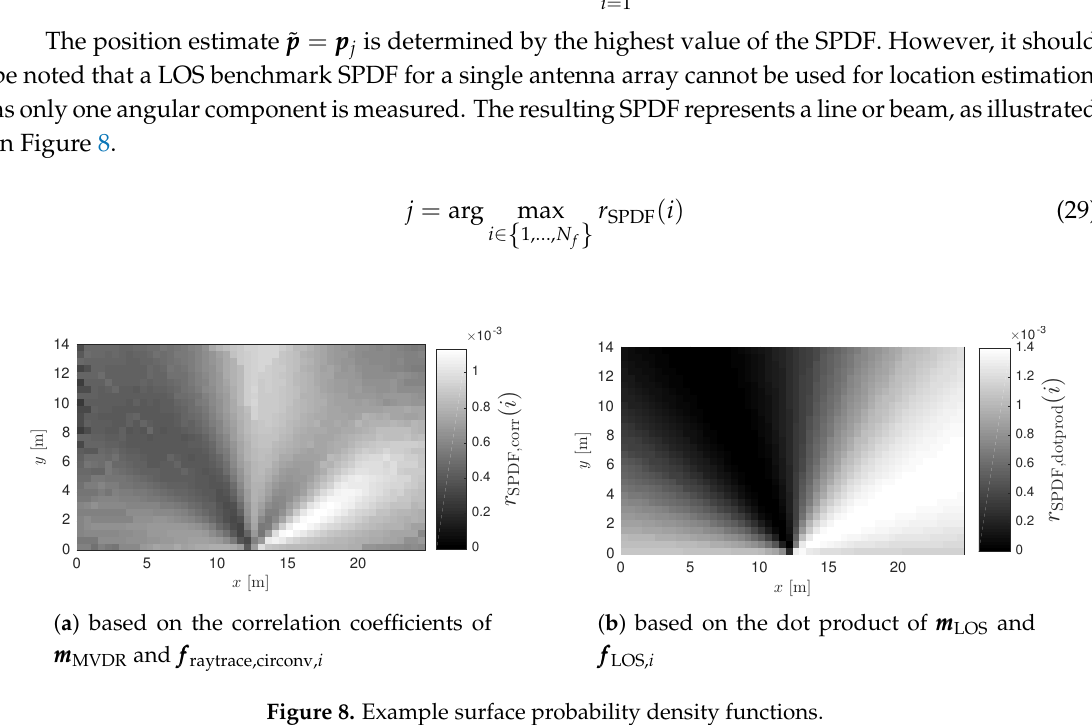
Figure 8. Example surface probability density